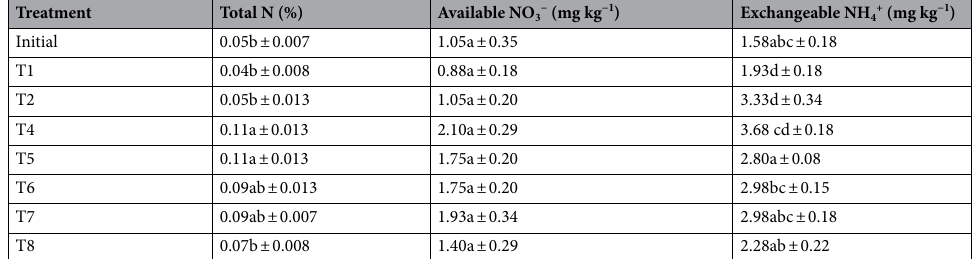
Table 4. Soil nitrogen concentrations measured after harvesting using chemical analysis method in the first planting cycle. Different letters within a row indicate significant difference between means of four replicates ± standard error using Tukey’s test at P ≤ 0.05.